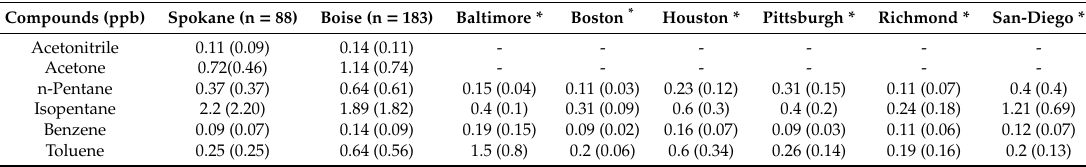
Table 2. Comparison of average mixing ratio (ppb) of VOCs measured at Boise and Spokane with other similar sites in the